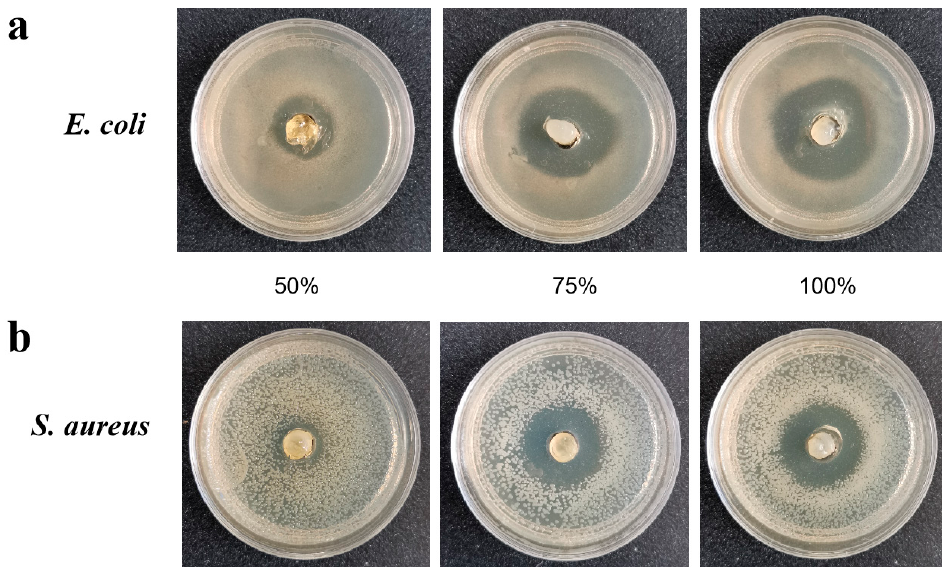
Figure 2. Zone of inhibition of various bacteria by Pen3a duckweed extracting solution. ( a ) Inhibition zone of different concentrations Pen3a duckweed extracting solution on Escherichia coli . ( b ) Inhibition zone of different concentrations Pen3a duckweed extracting solution on Staphylococcus aureus